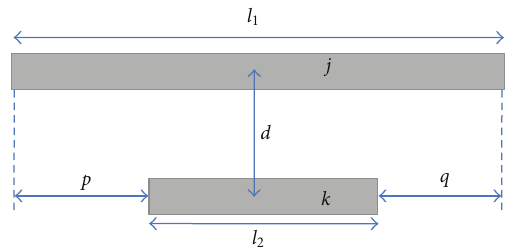
Figure 3: Cartridge and Printer Dimatix 2831 [17].